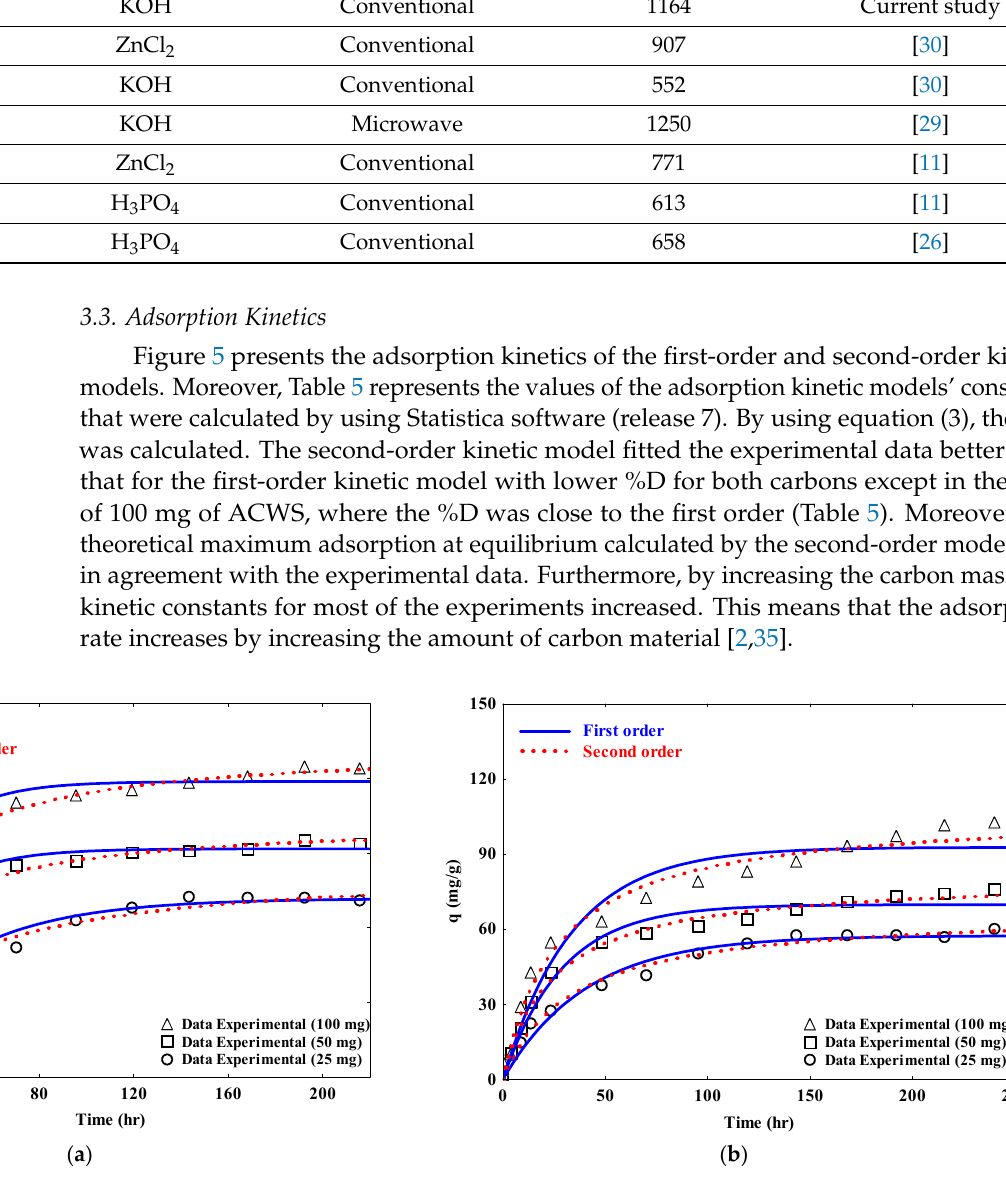
Figure 5. Adsorption kinetics of DPA onto ( a ) ACWS and ( b ) CACC at [C] o = 100 mg/L, T = 25 °C, pH ≈ 5 and at 25 mg ( ○ ), 50 mg ( □ ), and 100 mg ( ∆ ). Table 5. Adsorption kinetics data of DPA on activated carbons ACWS and CACC after applying the first and second-order models.